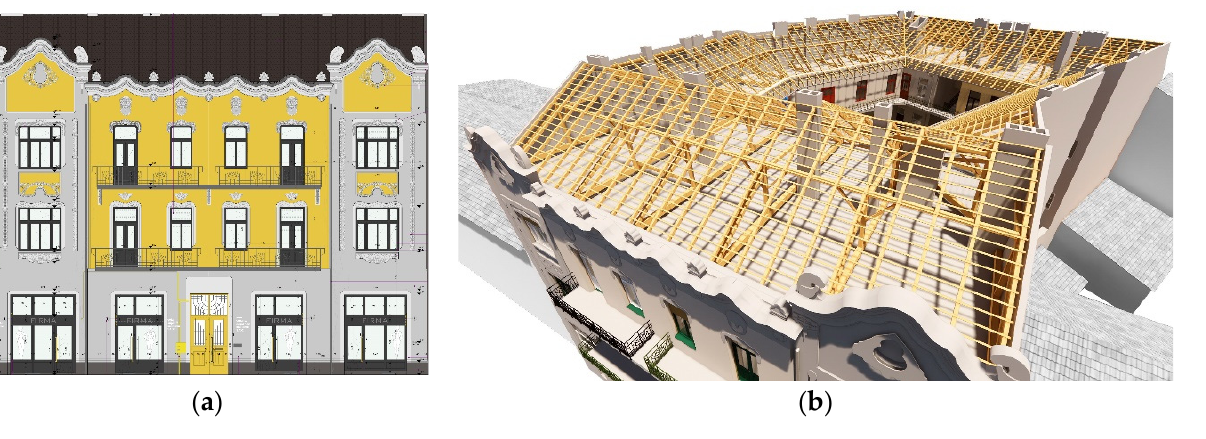
Figure 10. Technical elevation and 3D view of the Lajos (Ludwig) Besch and K á roly (Karl) Piffl Palace ( a ) Front view; ( b ) Roof view.